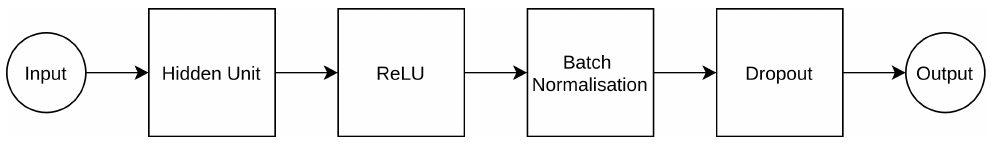
Figure 1. Operations within a hidden layer of the